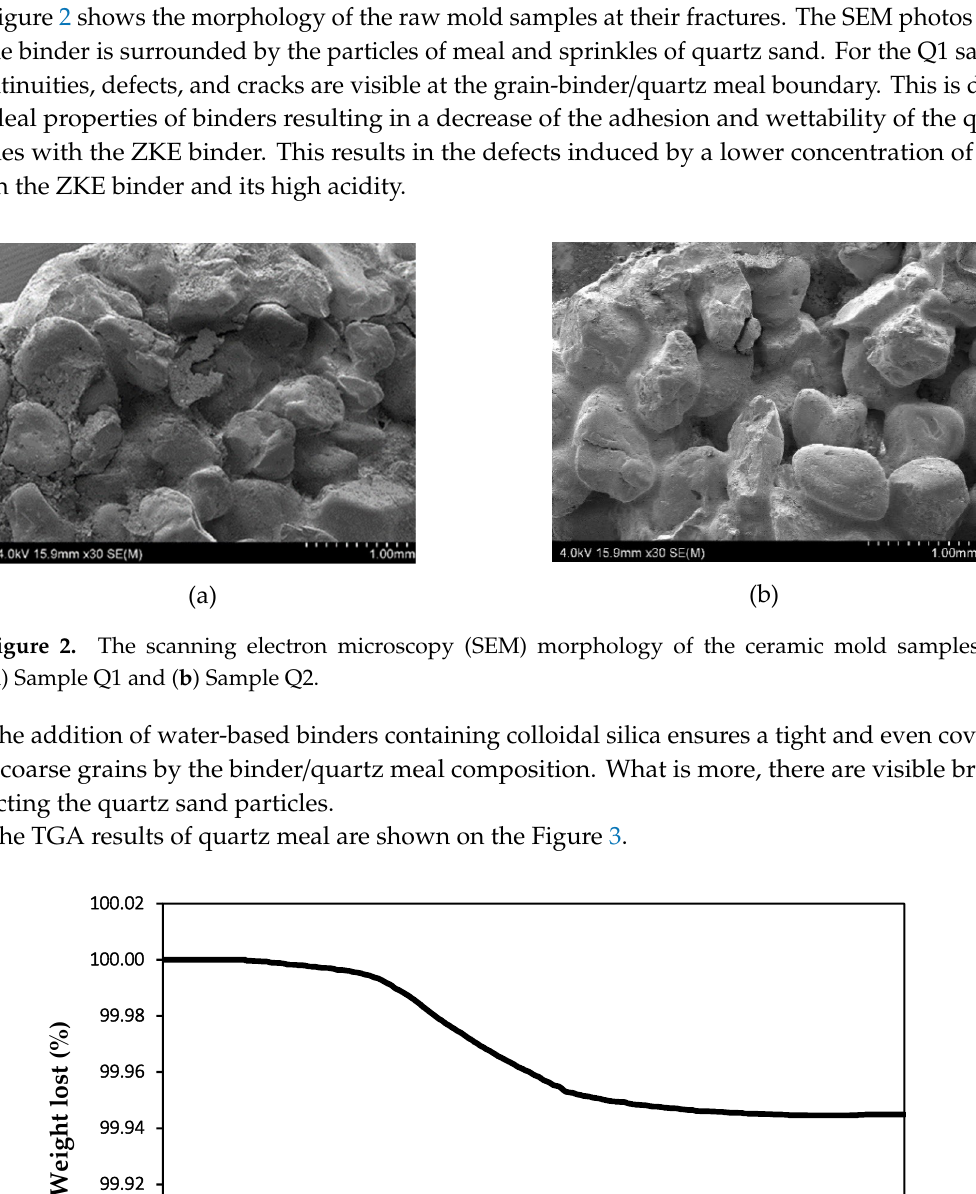
Figure 1. Morphology of powder particles used in the sample molds: ( a ) quartz meal; ( b ) silica sand 0.1–0.3 mm; and ( c ) silica sand 0.5–1.0 mm.